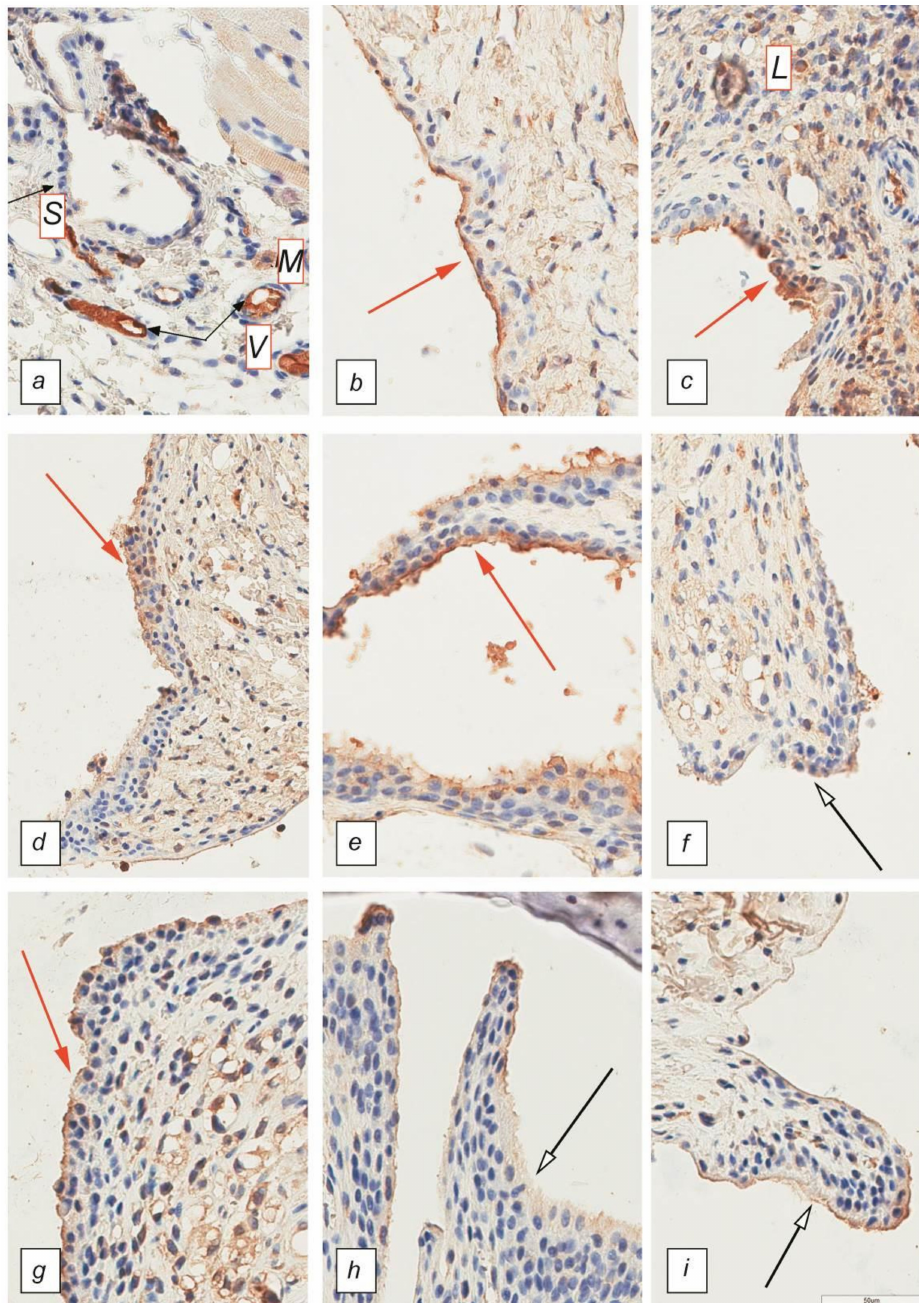
Figure 3. Synovial membrane of the metatarsophalangeal joints. Immunohistochemical staining with antibodies against TNF- α . Magnification 40 × . ( a ) Sham; ( b , c ) control after 7 and 21 days; ( d – f ) 7, 14, and 21 days after treatment with Cytos-11; ( g – i ) 7, 14, and 21 days after treatment with Humira. L—lymphocytes, M—macrophages, S—synoviocytes, V—vascular endothelium. Red arrows indicate high TNF- α expression in untreated groups as well as early treatment with Cytos-11 and Humira. White arrows indicate a decrease in TNF- α